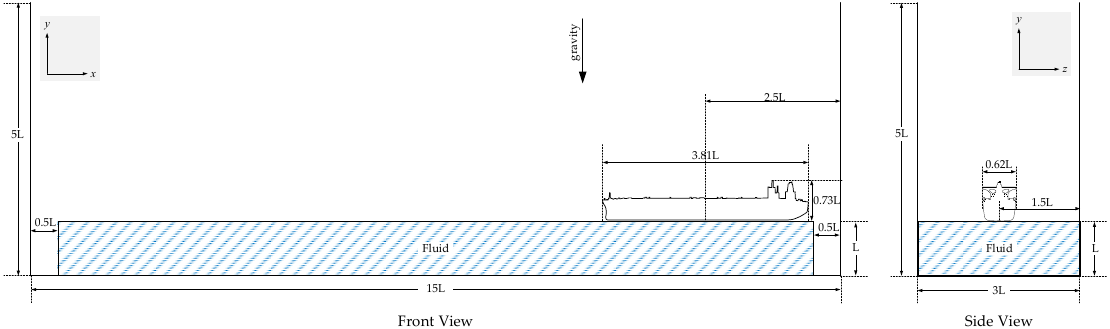
bottom of the bounding box.